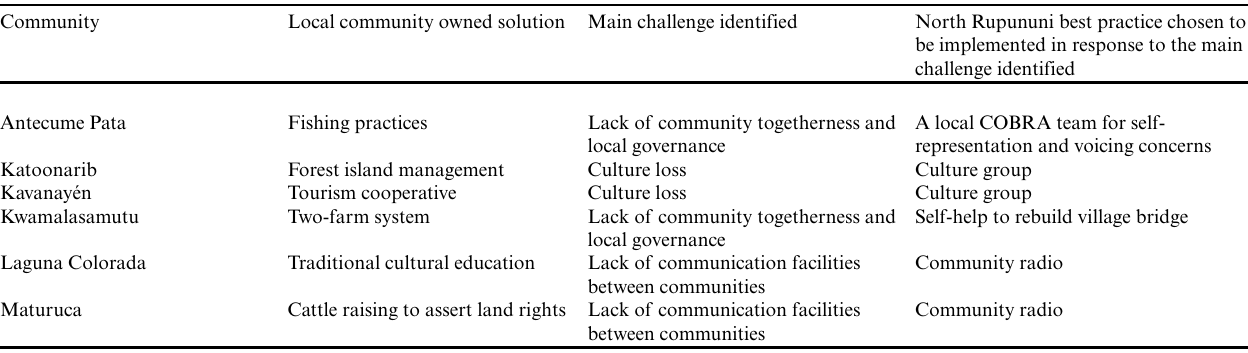
Table 2 . Solutions, challenges, and North Rupununi best practices chosen to implement in the six communities of the Guiana